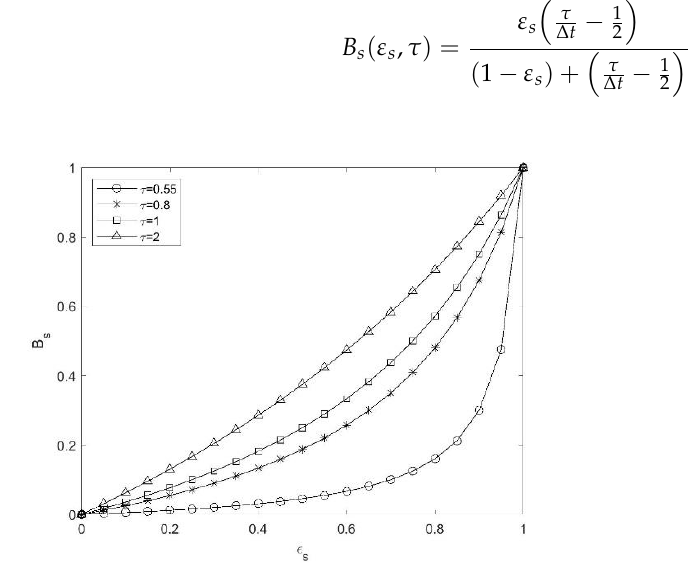
Figure 4. Polynomial 𝐵 𝑠 depends on 𝜀 𝑠 .